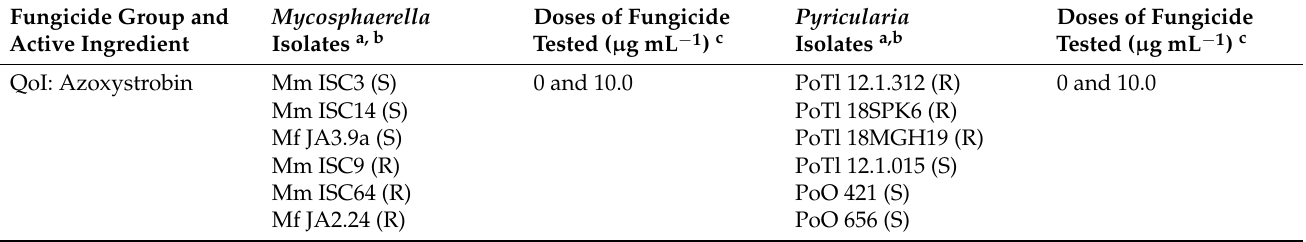
Table 1. Mycosphaerella and Pyricularia isolates selected for this study, their fungicide resistance categories, and doses of QoI, DMI, and SDHI fungicides